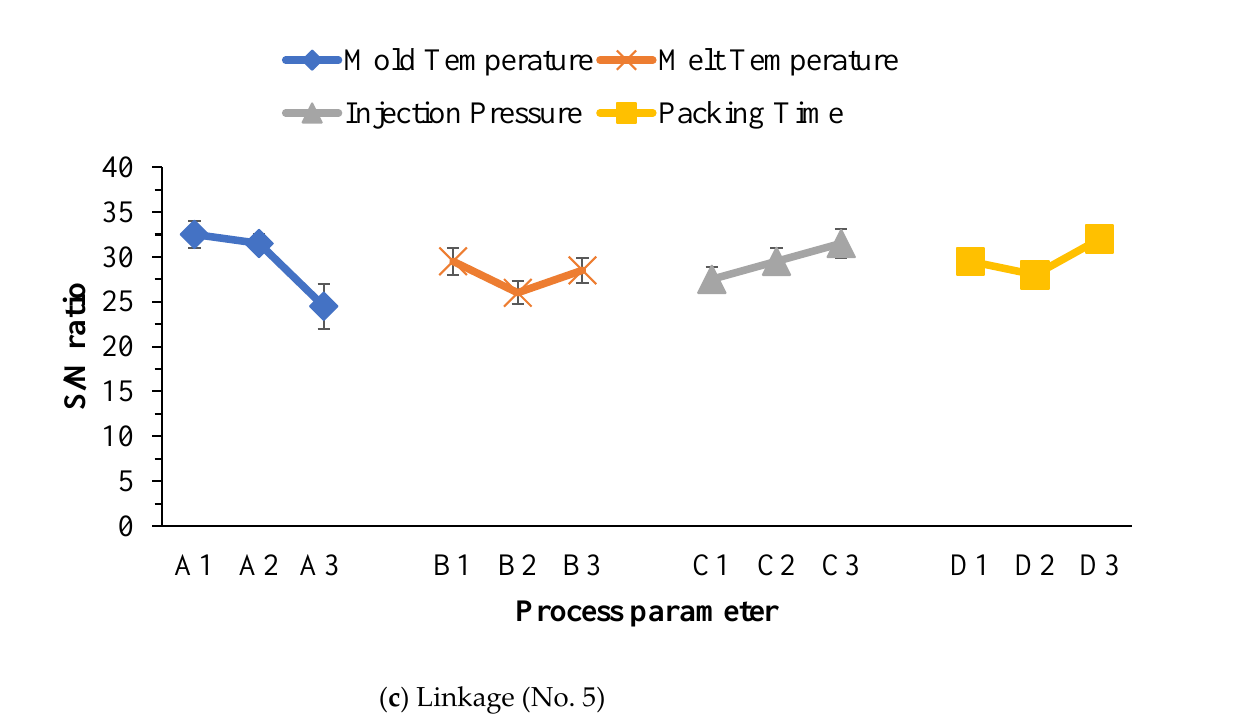
Figure 7. Variation of the S/N ratio with factor levels for warpage of various parts of the flapping-wing MAV.